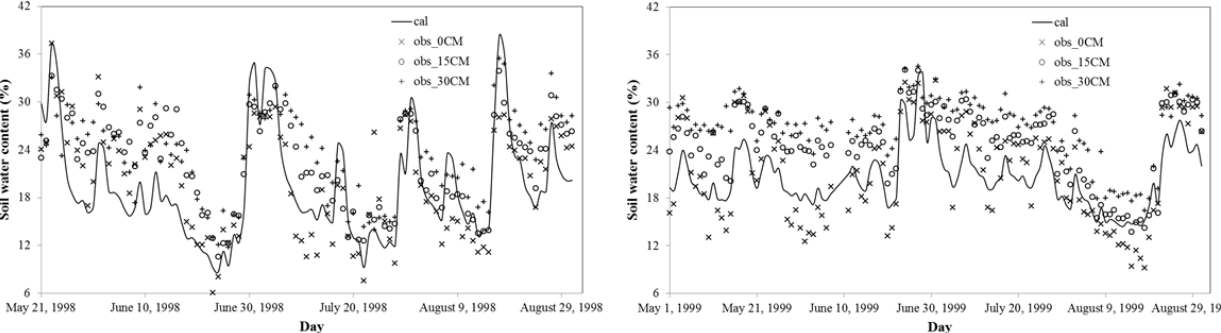
Figure 4. Comparison of the calculated results and observed soil water content.